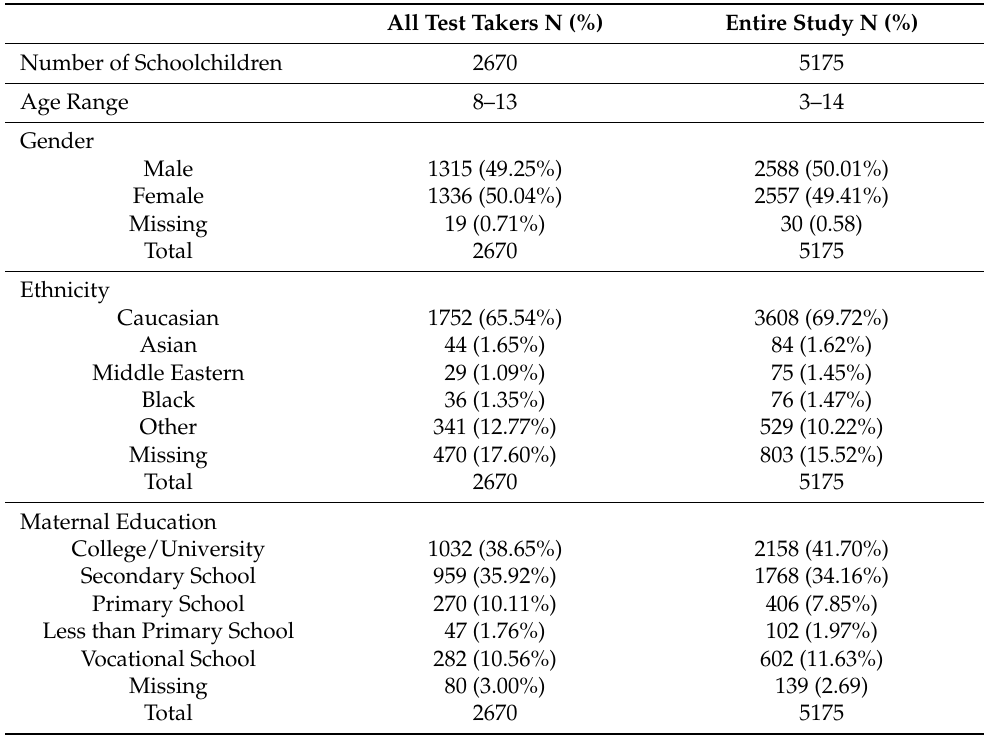
Table 2. Demographic information on performance test takers within the SINPHONIE Study (N =